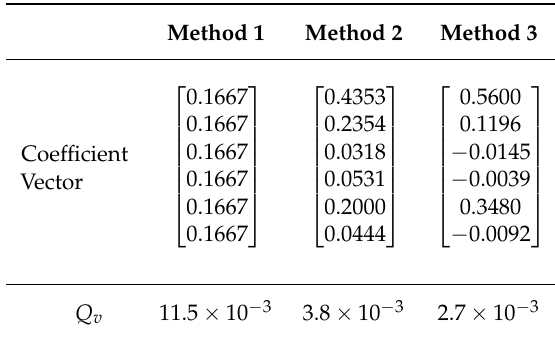
Table 1. Coefficient vectors for a 6-gyro array and corresponding RRW spectral density Q v using three methods. Method 1 is the unweighted average of the gyro signals. Method 2 uses only the diagonal elements of the theoretical Q matrix to calculate the coefficients. Method 3 is the optimal linear combination, which is calculated using the entire Q